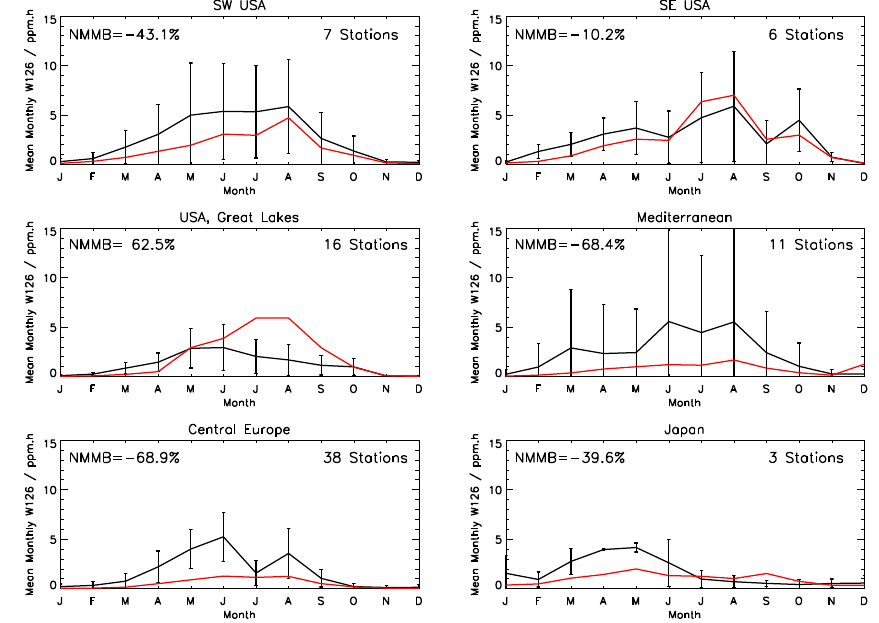
Fig. 6. As Figure 3, but for the monthly-average W126 metric (see main text for definition).